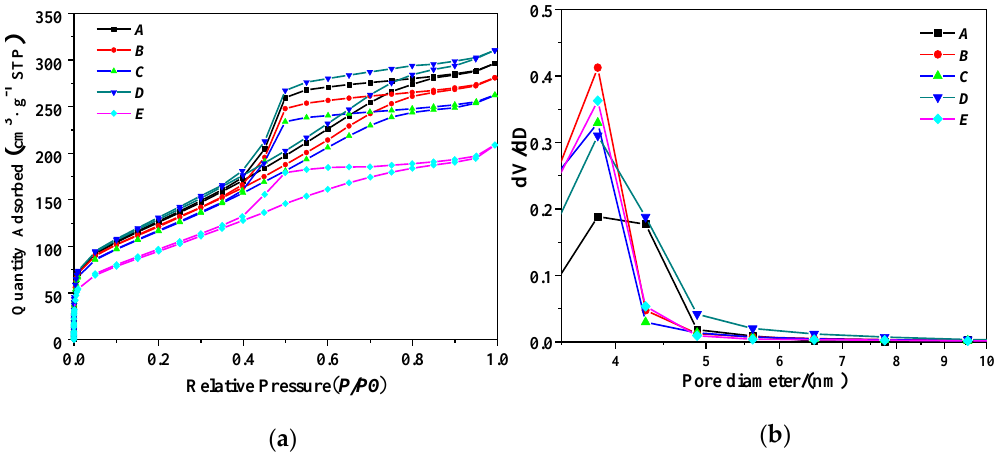
Figure 3. XRD results of PB with different concentrations of NaAlO 2 solution (gas – liquid ratio. 1:1; rotating speed of CF-RPB, 600 rpm) .